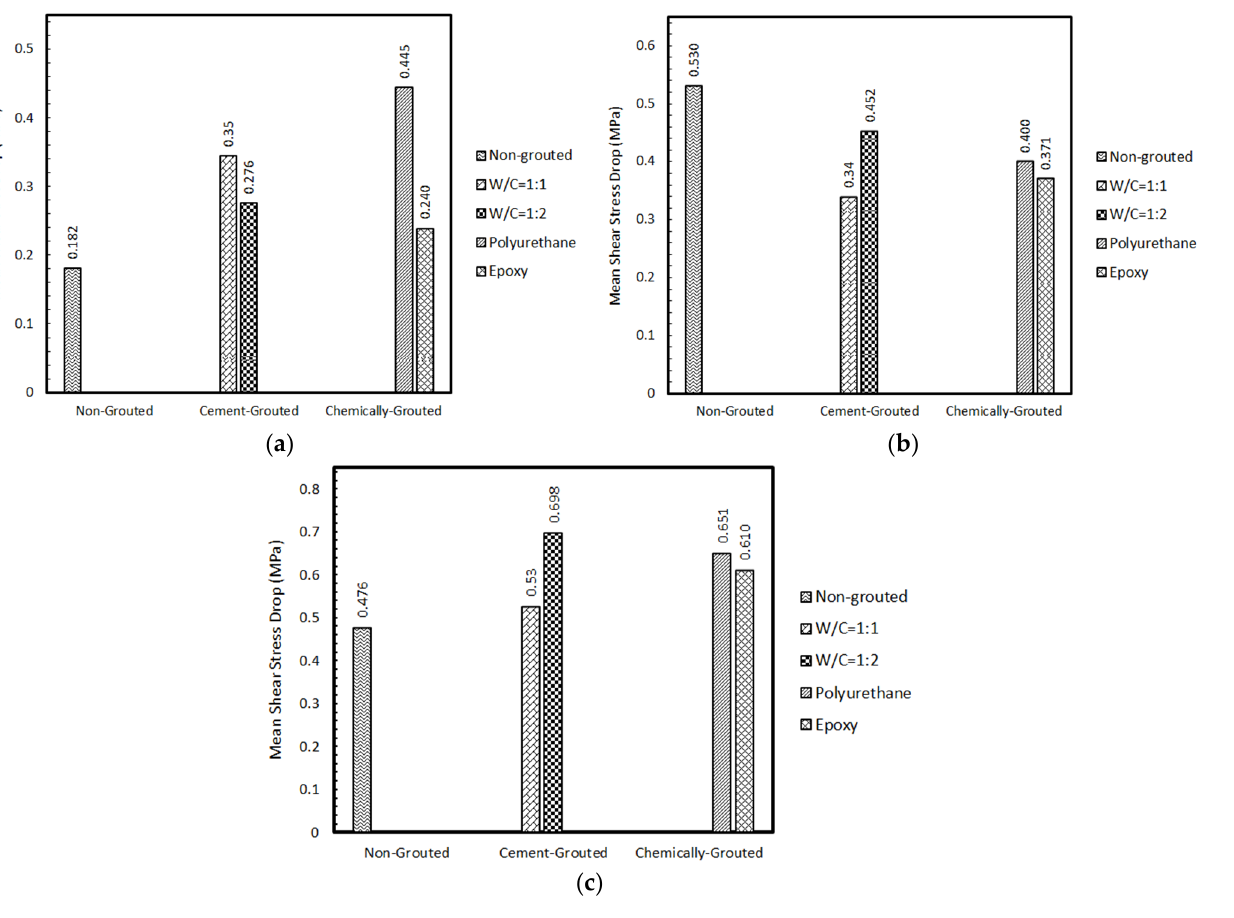
Figure 9. Comparison of mean shear stress drops across various joints tested. ( a ) JRC = 7.8, ( b ) JRC = 12.4, ( c ) JRC = 17.6 .